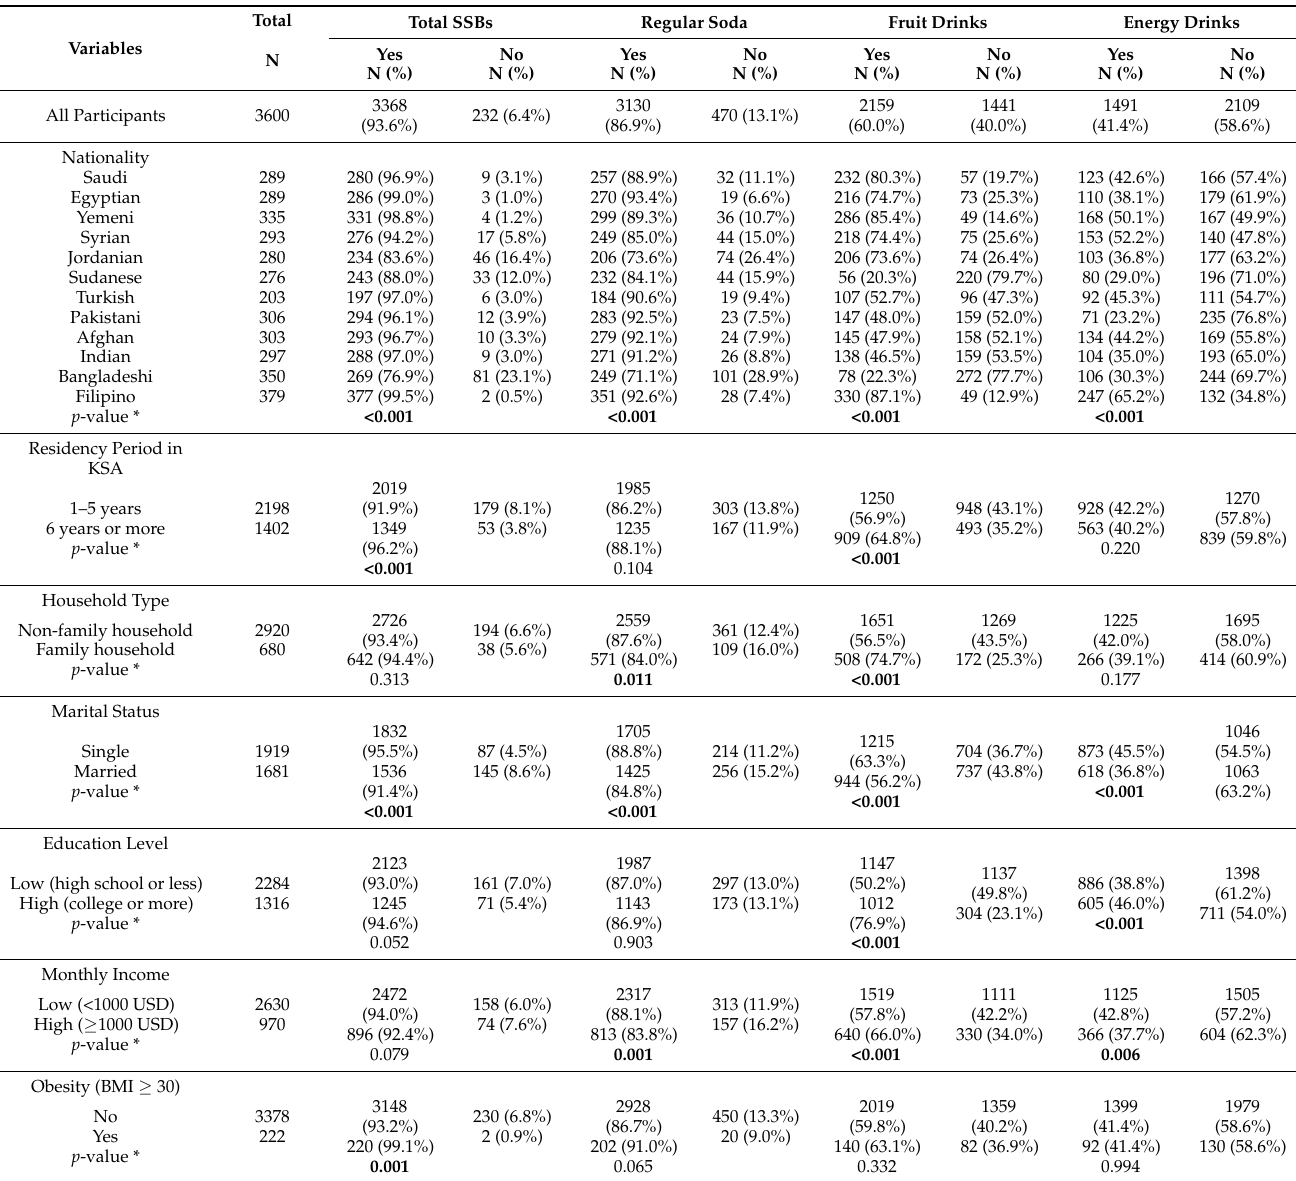
Table 1. Prevalence of weekly sugar-sweetened beverage (SSB) consumption among study partici- pants ( n = 3600) stratified by sociodemographic characteristics and